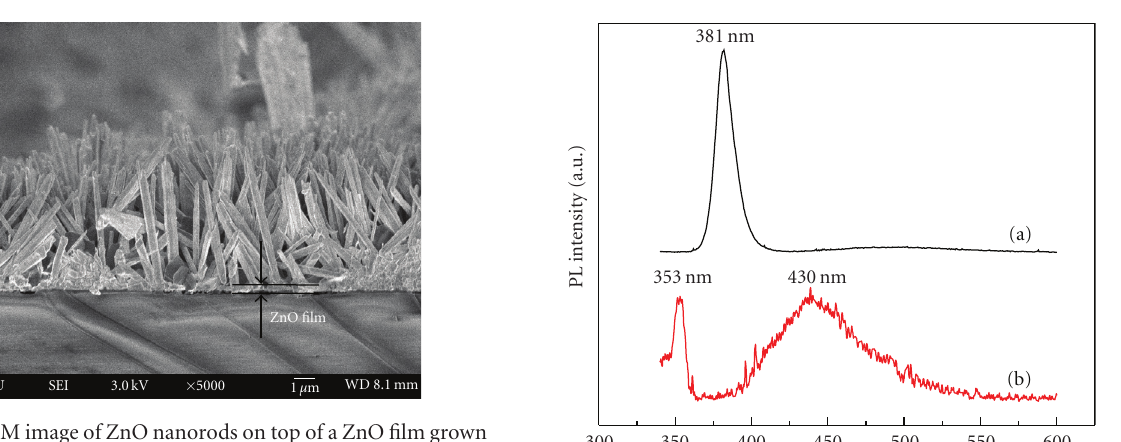
Figure 3: SEM image of ZnO nanorods on top of a ZnO film grown by the two-step CBD method.